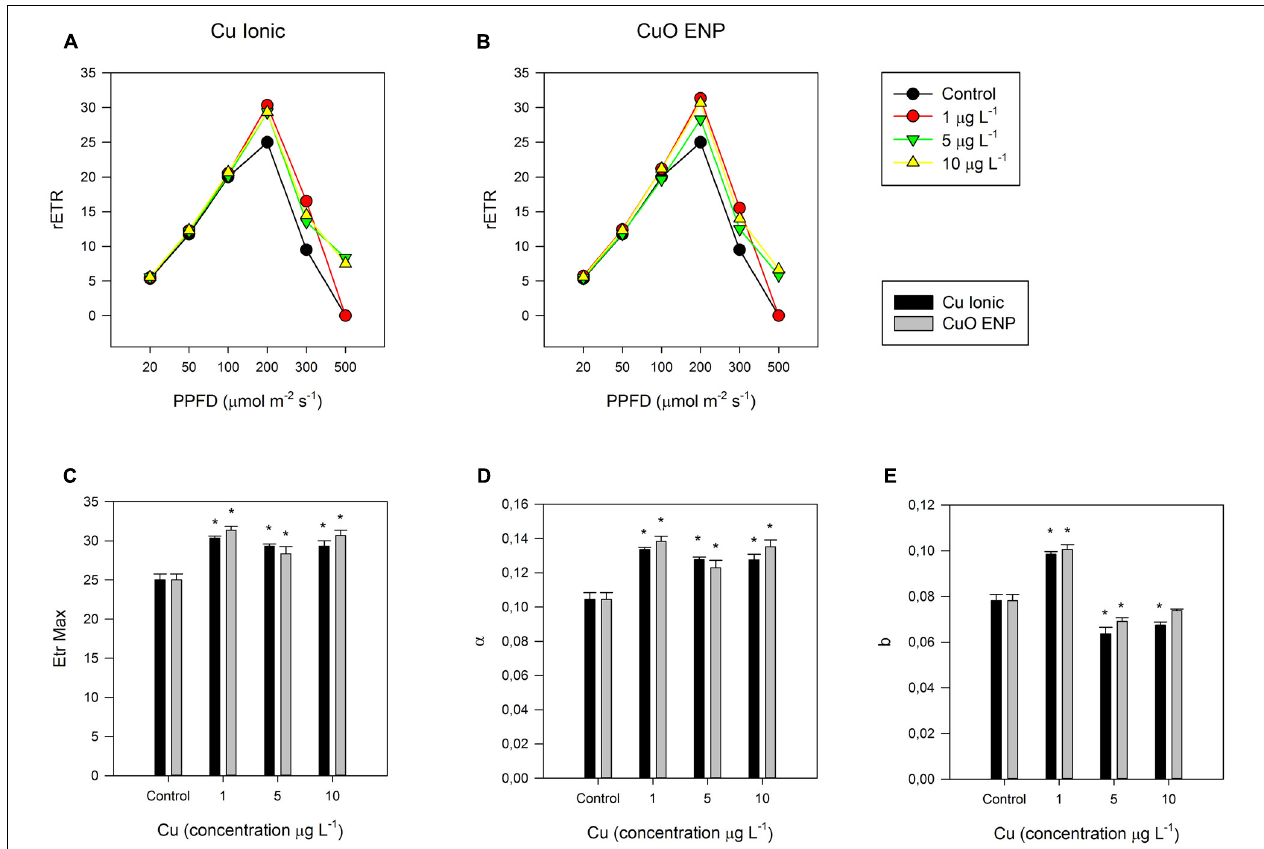
FIGURE 3 | (A,B) Rapid light curves and derived parameters: (C) maximum electron transport rate (ETR max ), (D) photosynthetic ( α ), and (E) respiratory ( β ) efficiency in P. tricornutum , after 3 days of exposure to increasing ionic Cu (black bars) and CuO ENP (gray bars) concentrations (average ± standard deviation, N = 3, *indicate significant differences compared with the control at p <